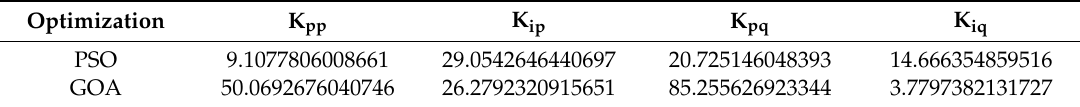
Table 2. Optimized proportional integral (PI) controller parameters.